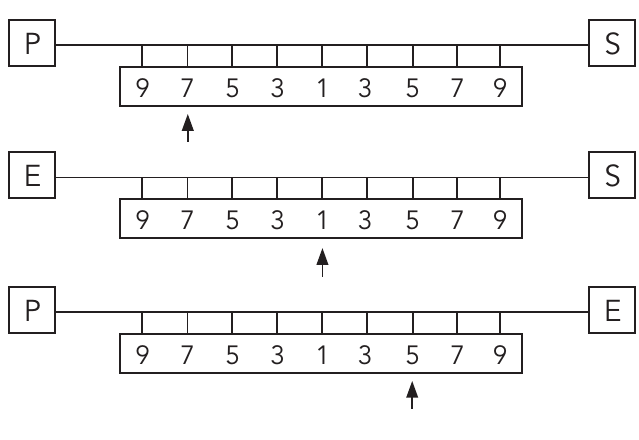
Figure 4: Pair-wise comparison of three criteria